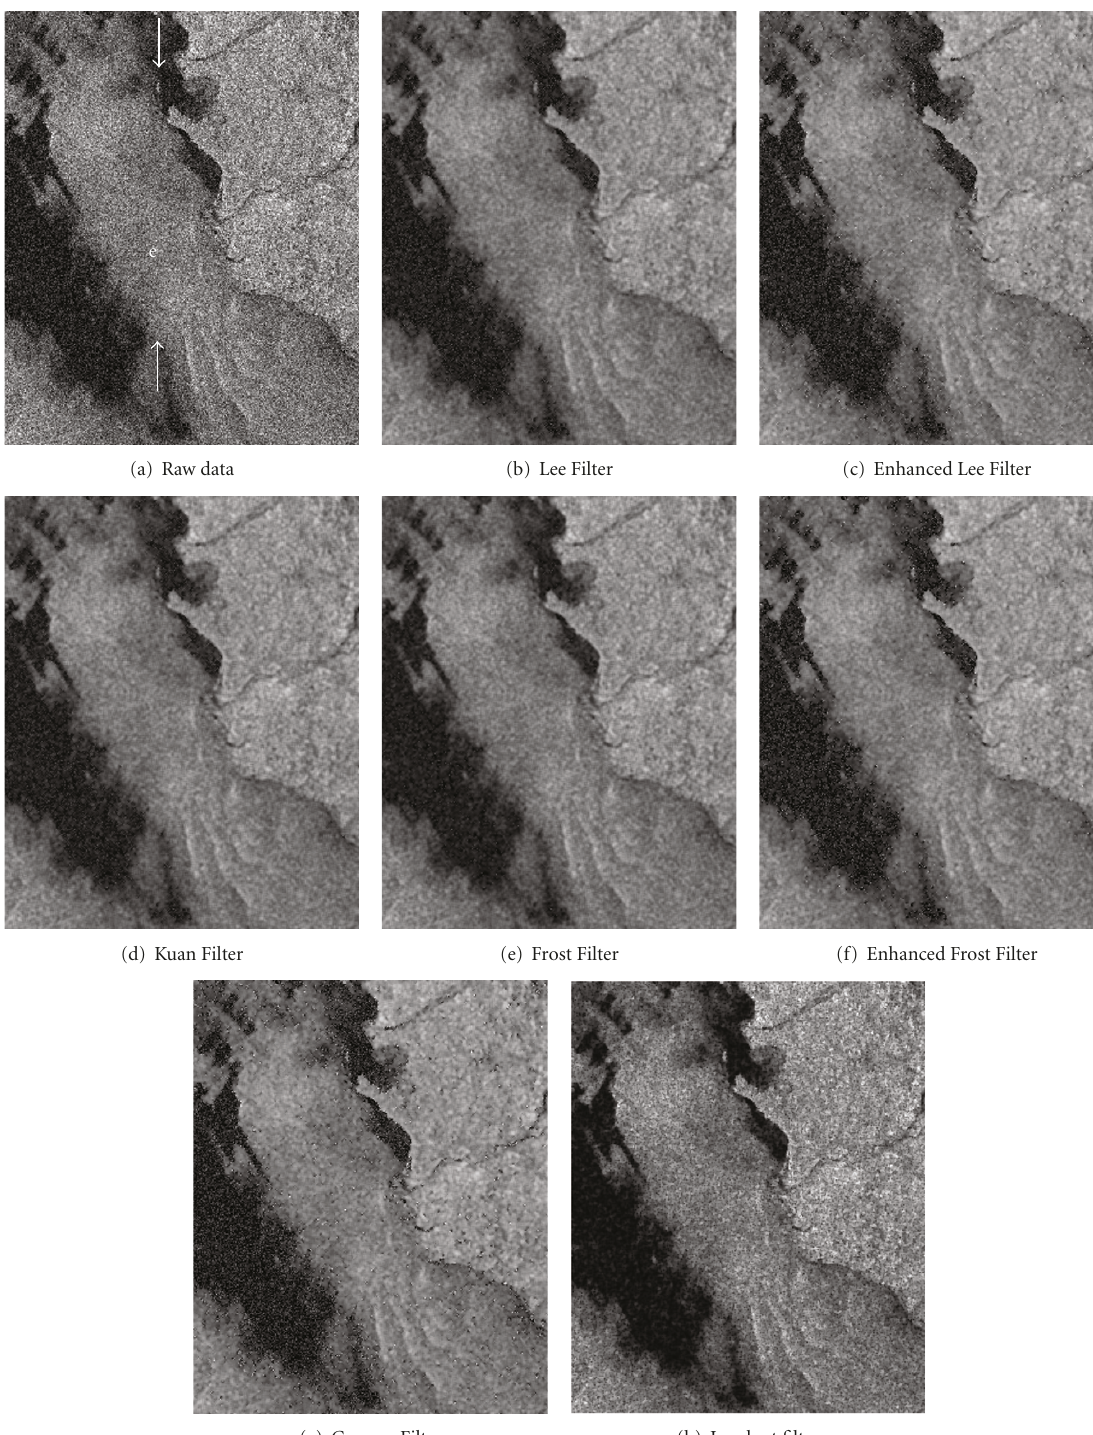
Figure 6: The proposed level set-based filter in contrast to the conventional approaches of seascape ERS-2 SAR image.